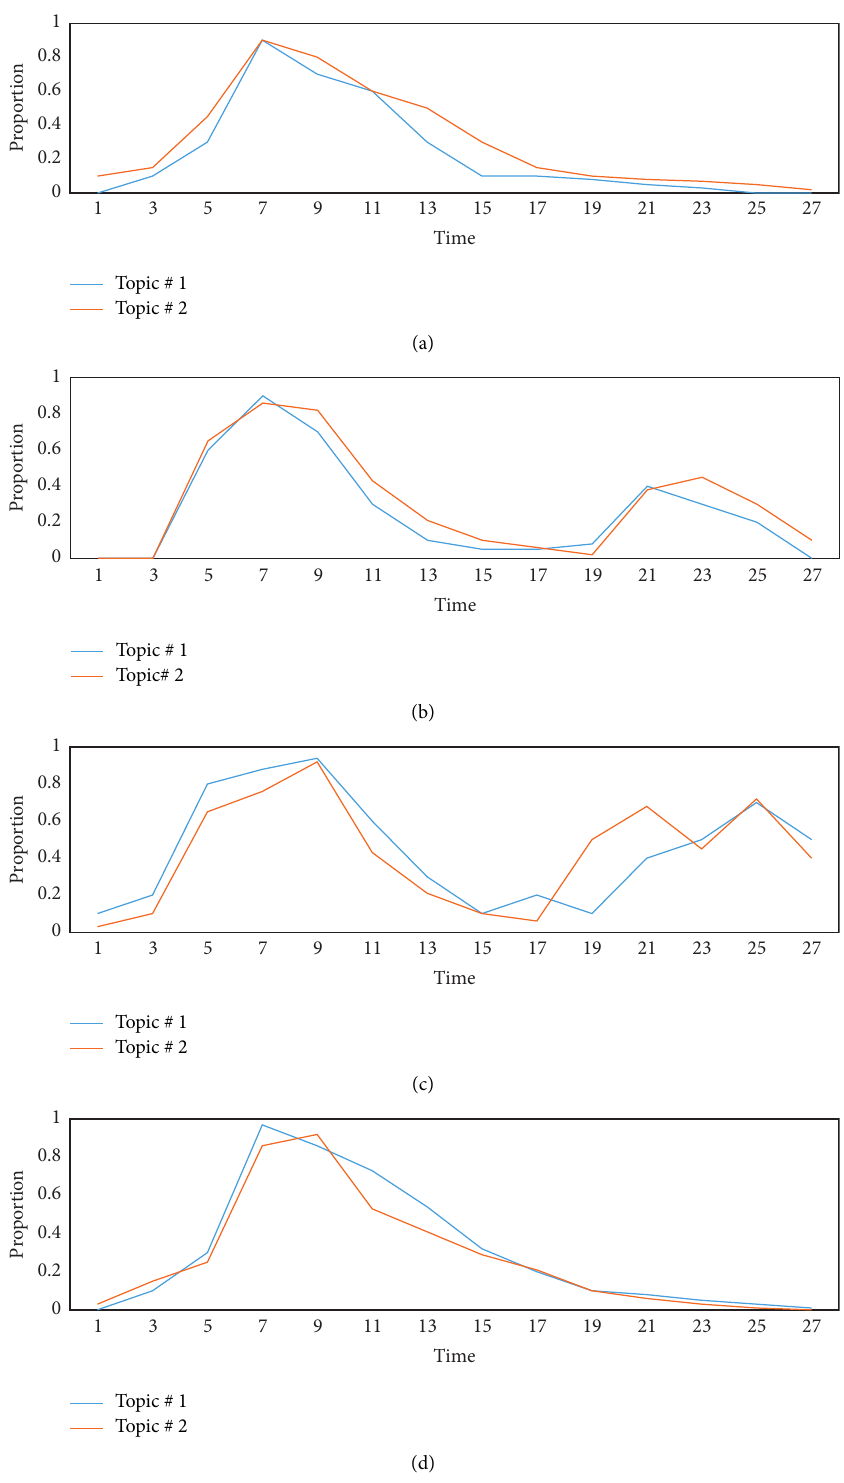
Figure 6: The changing of topics in four datasets. (a) Military parade in National Day. (b) The assault on a doctor. (c) Hong Kong’s event. (d) Garbage sorting in